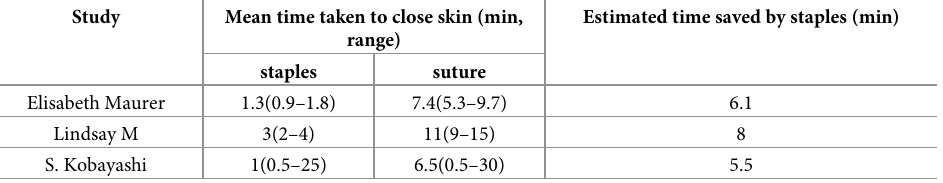
Table 2. Operating time reported in selected studies comparing staples with subcuticular sutures for skin closure after abdominal surgery. Study Mean time taken to close skin (min,